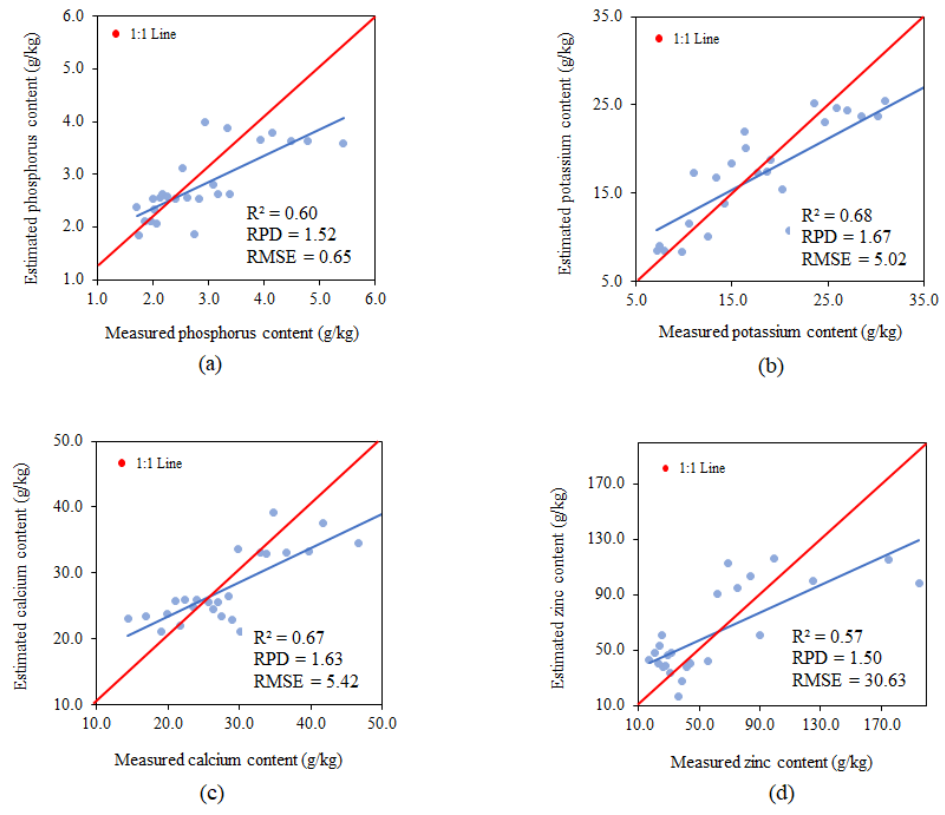
Figure 9. Relationships between the measured and estimated P ( a ), K ( b ), Ca ( c ) and Zn ( d ) content, using the band-ratio model.